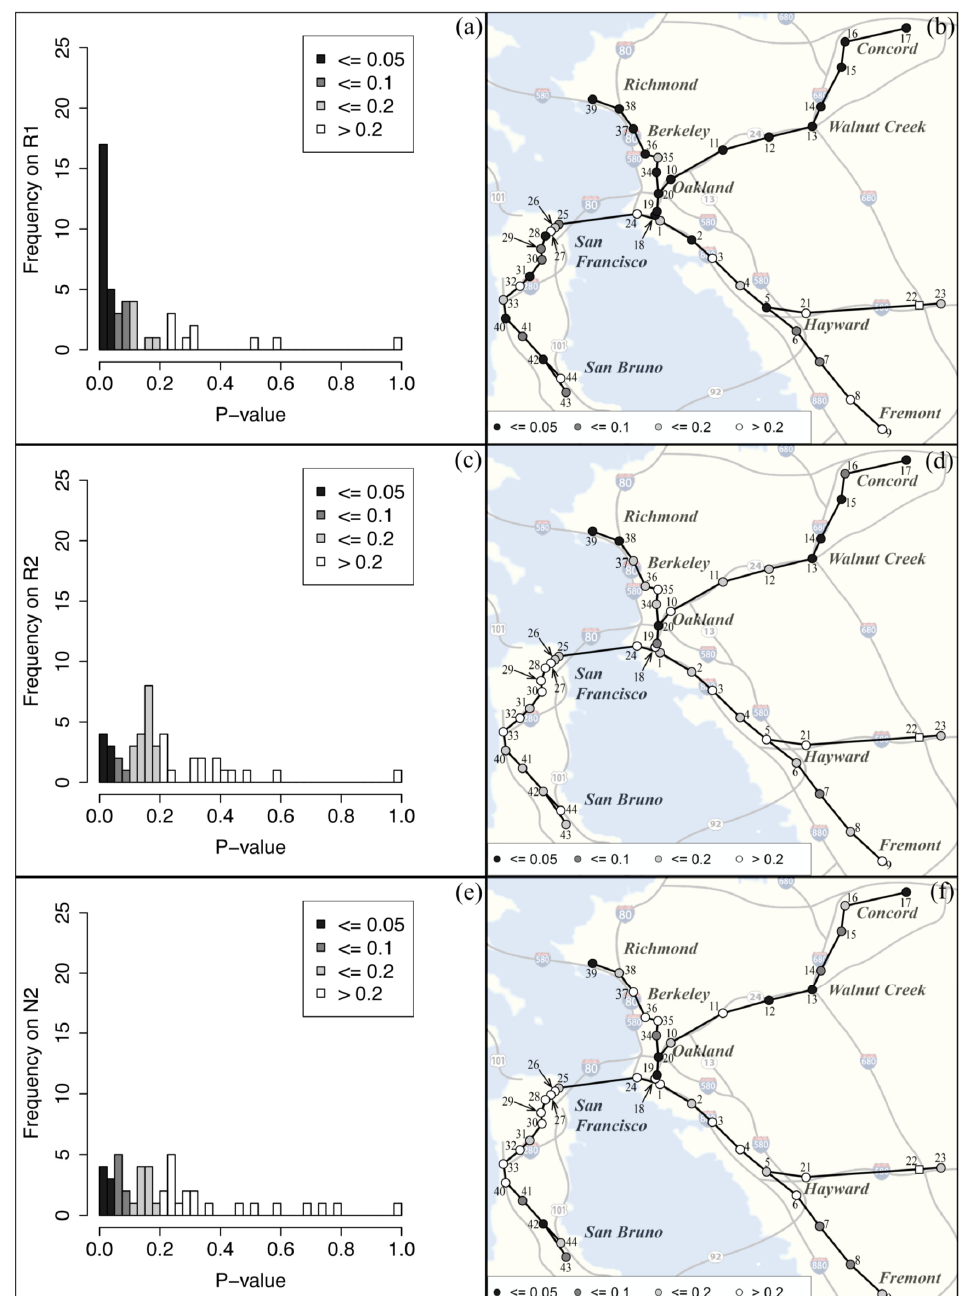
Figure 3. ( a ) Histogram of p ‐ values of the average weekday daily BART entrance ridership during R1; ( b ) map of values shown in Figure 3a; ( c ) histogram of p ‐ values of the average weekday daily BART entrance ridership during R2; ( d ) map of values shown in Figure 3c; ( e ) histogram of p ‐ values of the average weekday daily BART entrance ridership during N2; and ( f ) map of values shown in Figure 3e.